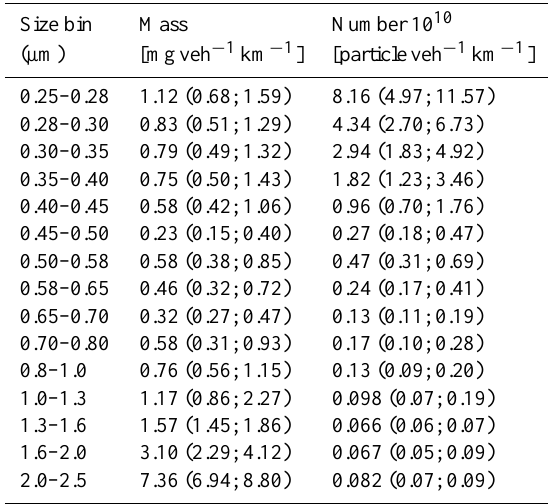
Table 1. Median mass and number emission factor for each of the 15 OPC size bins. Values in brackets represent the 95% confidence interval.